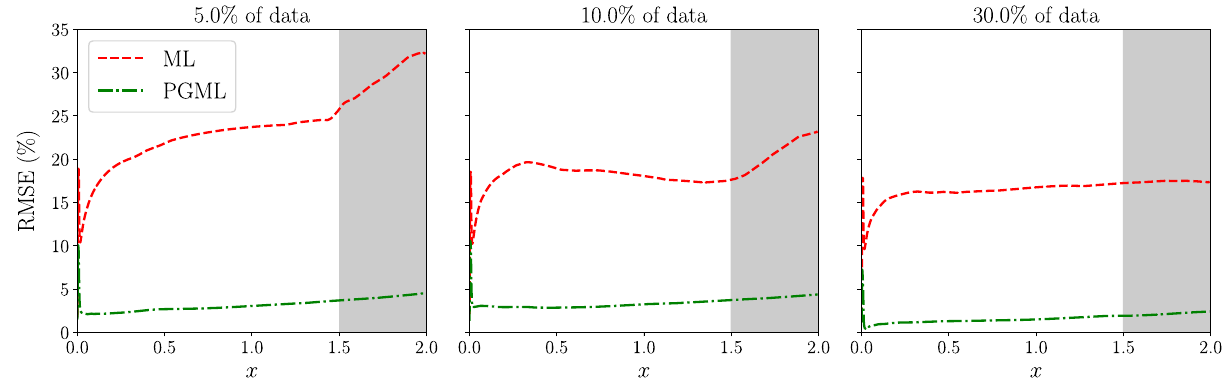
Figure 9. Variation of the normalized RMSE (in percentage) along the streamwise direction for ML and PGML models. The amount of observations data used for training the model is 5% (left), 10% (middle), and 30% (right). The gray color shaded area represents the extrapolation